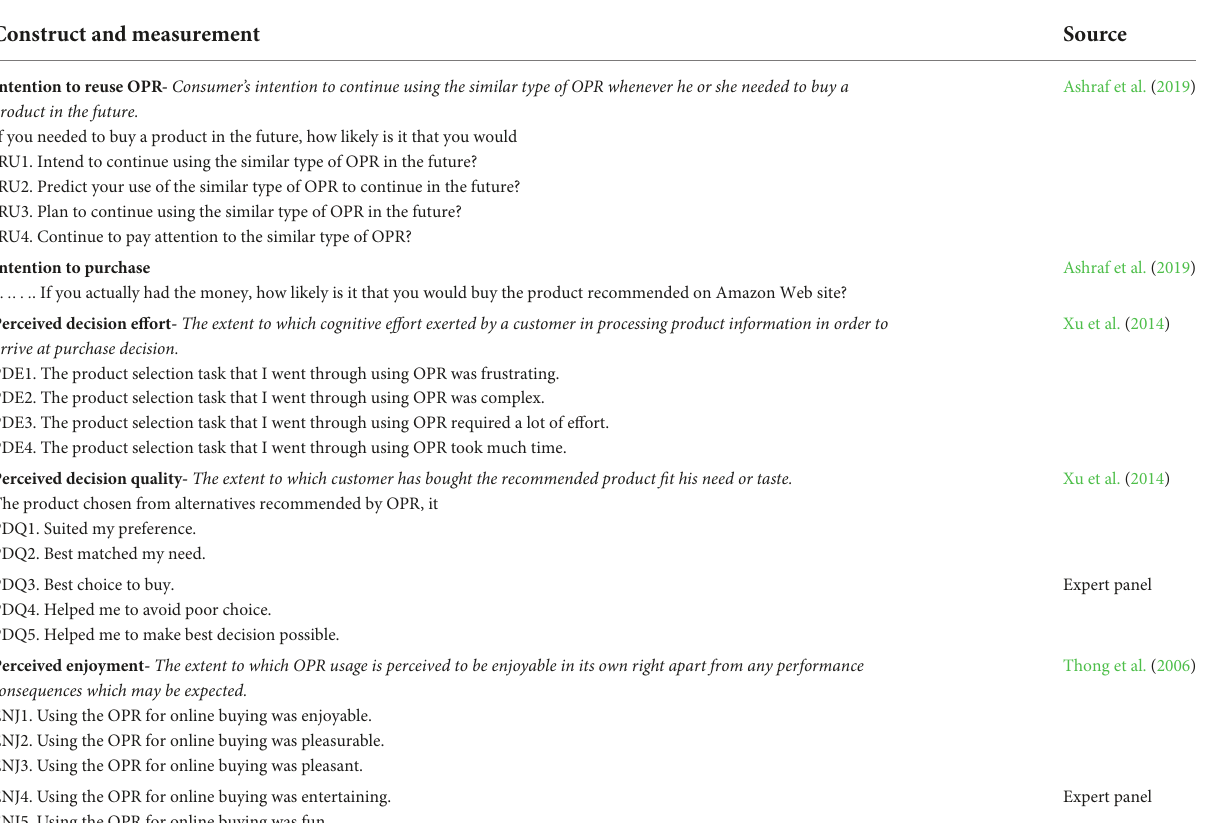
TABLE 1 Construct